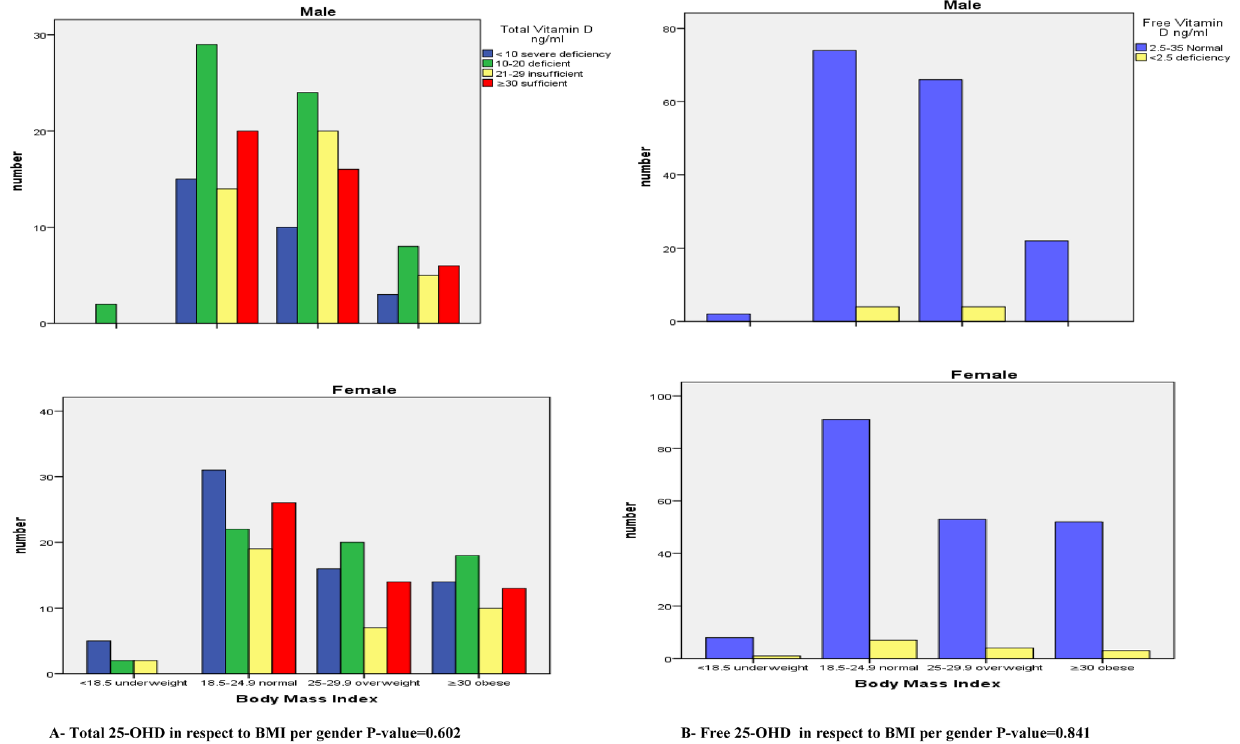
Figure 3. Total and Free 25-OHD in respect to BMI per gender. ( A ) Total 25-OHD in respect to BMI per gender P-value = 0.602, ( B ) Free 25-OHD in respect to BMI per gender P-value = 0.841.